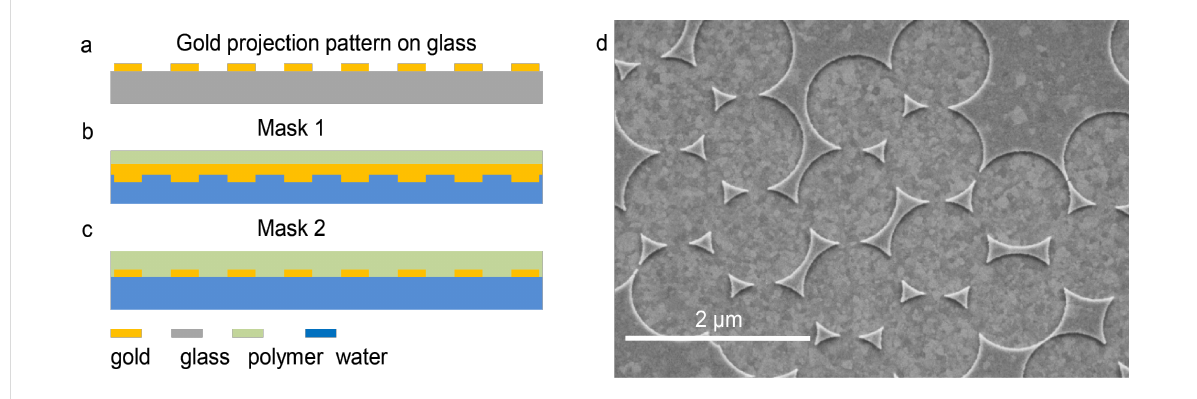
Figure 1: Schematic representation of the mask fabrication processes. (a) Colloidal lithographic gold projection patterns on glass. (b) Mask 1, supported by a metal film, floating on water ready for use. (c) Metal mask 2, embedded in polystyrene matrix, floating on water. (d) Scanning electron micrograph of mask 1, a metal-supported CL projection